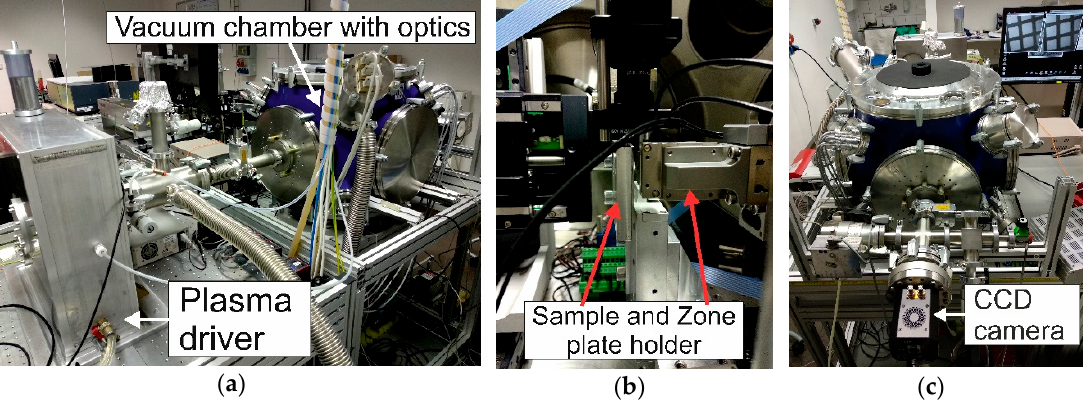
Figure 3. Photographs of the soft X-ray (SXR) imaging system: ( a ) The “source” view showing plasma driver and vacuum chamber with imaging optics, ( b ) the internal photograph of a vacuum chamber with sample and zone plate holder, ( c ) photograph of the “imaging” part of the SXR microscope.